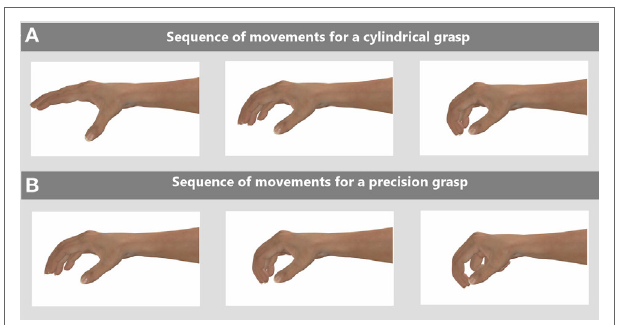
FigUre 1 | Two exercises people need to perform to complete daily living tasks are cylindrical and pinch grasps, the range of motions required for these tasks are shown in these two sequences for: (a) a cylindrical grasp and (B) a pinch grasp . Rehabilitation exercises for stroke patients aim to help restore these